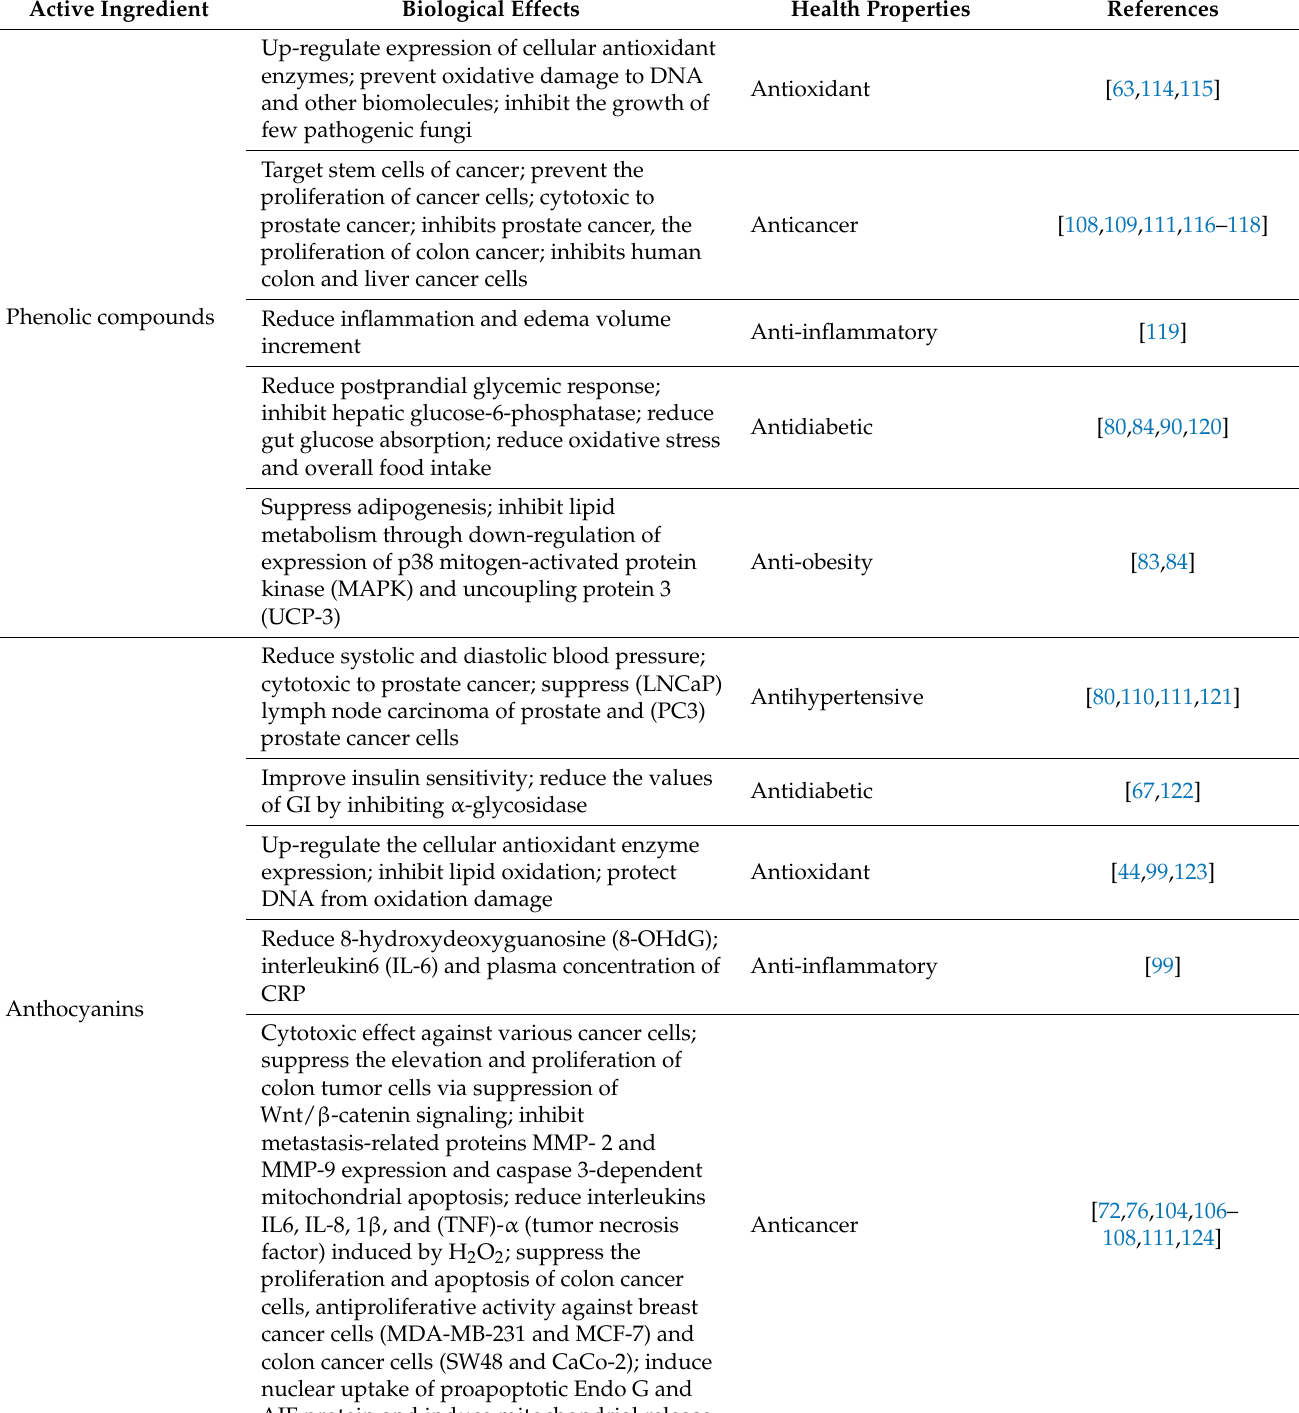
Table 3. Health properties and physiological effects of potato